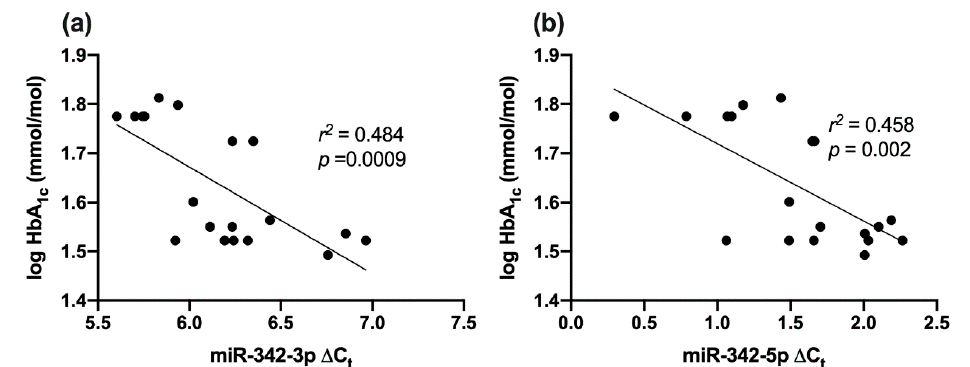
Figure 4. Correlation between miR-342-3p/-5p and glycemic control in type 1 diabetes and healthy